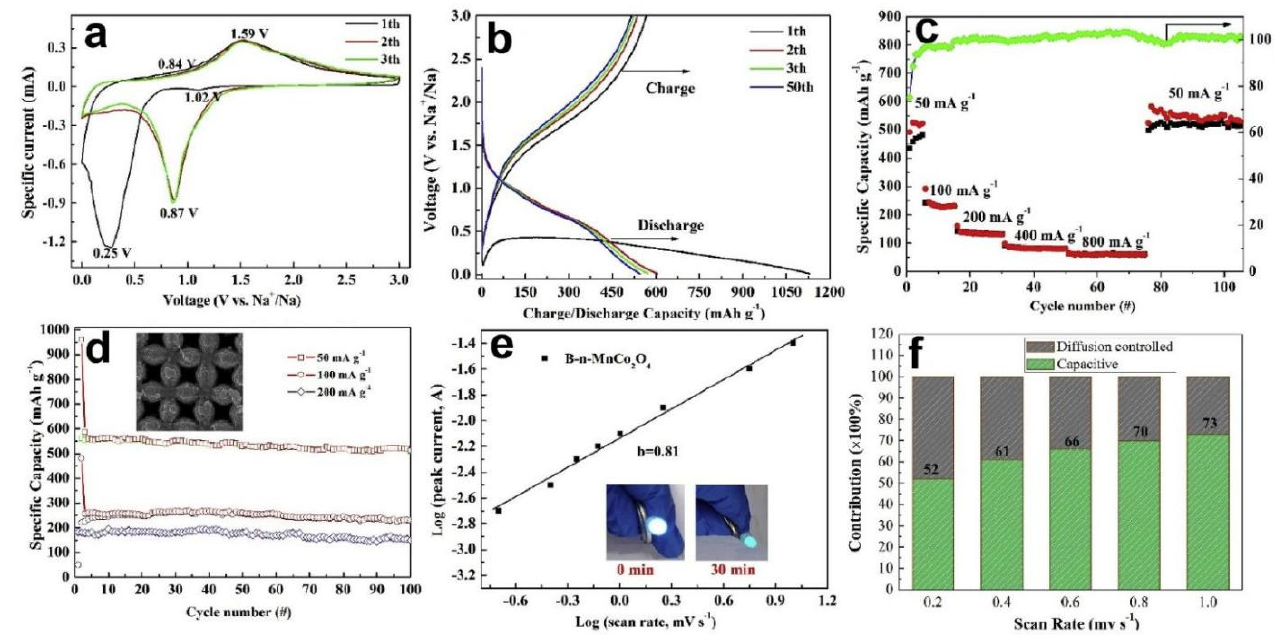
Figure 12. Electrochemical properties of the MnCo 2 O 4 @n-MECN based SIBs: ( a ) CV curves; ( b ) 1st, 2nd, 3rd, and 50th GCD curves at 50 mA g − 1 ; ( c ) Rate capability performance and Coulombic efficiency from 50 mA g − 1 to 800 mA g − 1 ; ( d ) Cycling stability at 50, 100, and 200 mA g − 1 ; ( e ) Relationship between log scanning rates and log cathodic peak currents; ( f ) Normalized contribution ratio at different scan rates. Reproduced with permission [79]. Copyright 2020, Elsevier.